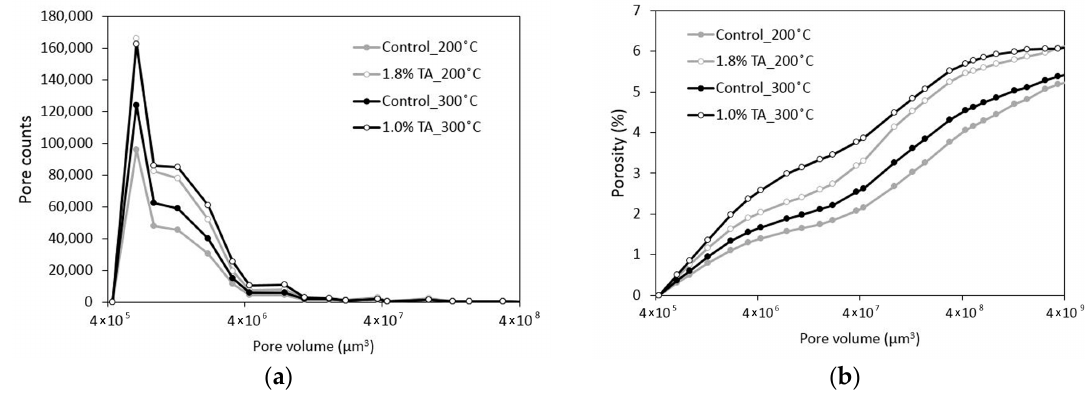
Figure 2. ( a ) Calculated pore counts; and ( b ) related cumulative volume (porosity).